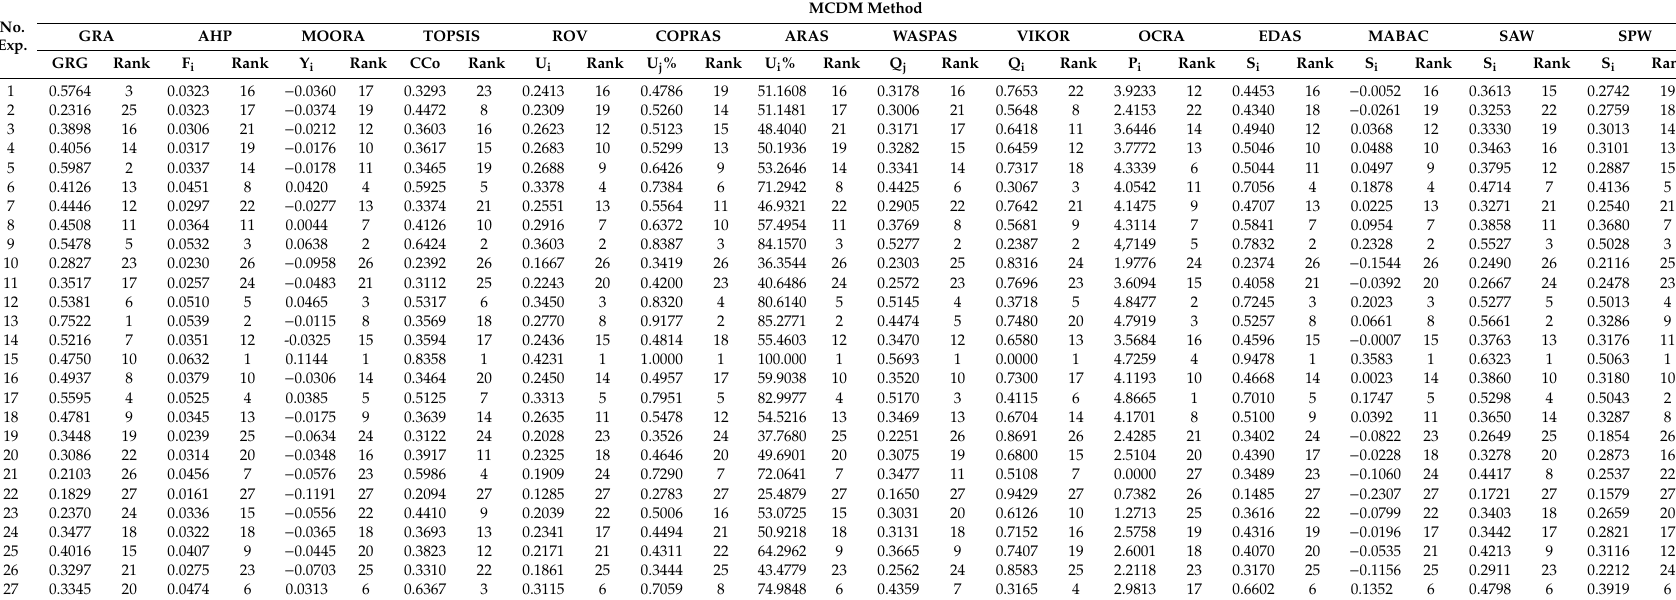
Table 6. Resulting coe ffi cients of applying multi-criteria decision making (MCDM) methods and the rank of the alternative levels. No.